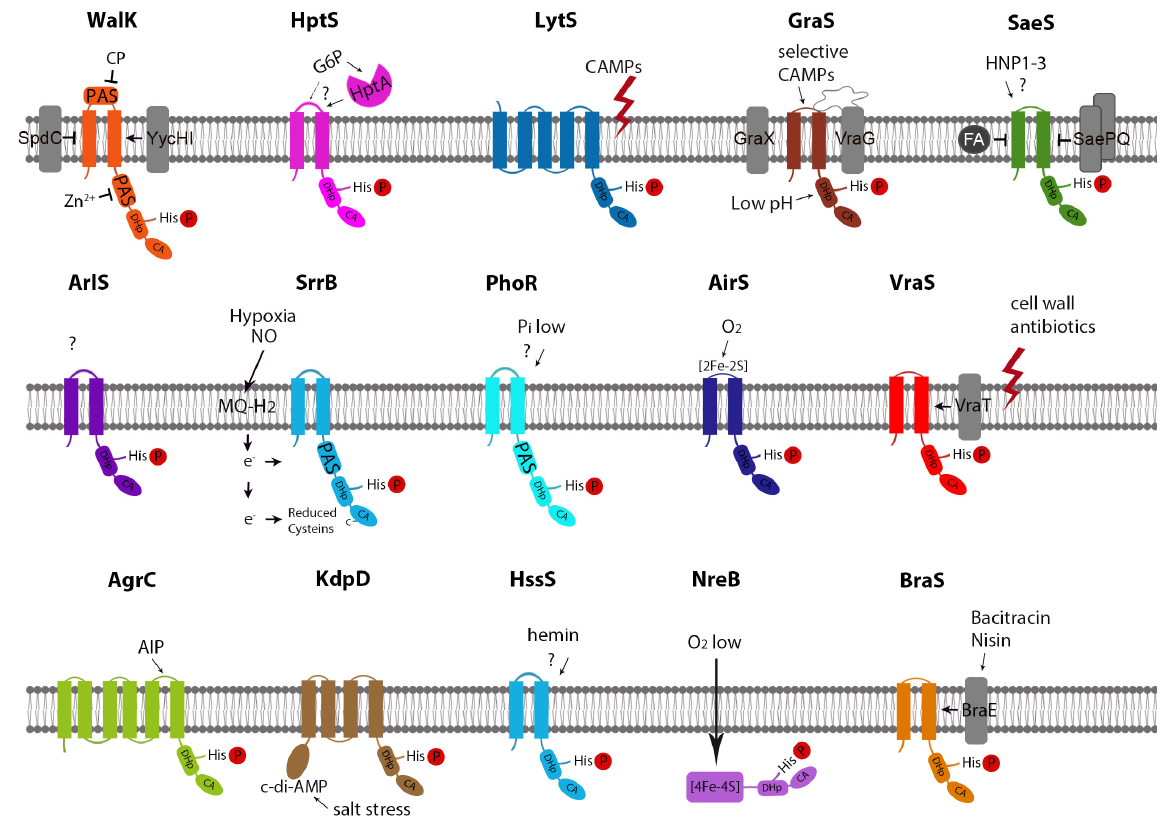
Figure 1. Structure and Signaling-Mechanisms of S. aureus HKs. CP: Peptidoglycan cleavage products; CAMP: Cationic antimicrobial peptide; FA: fatty acid.